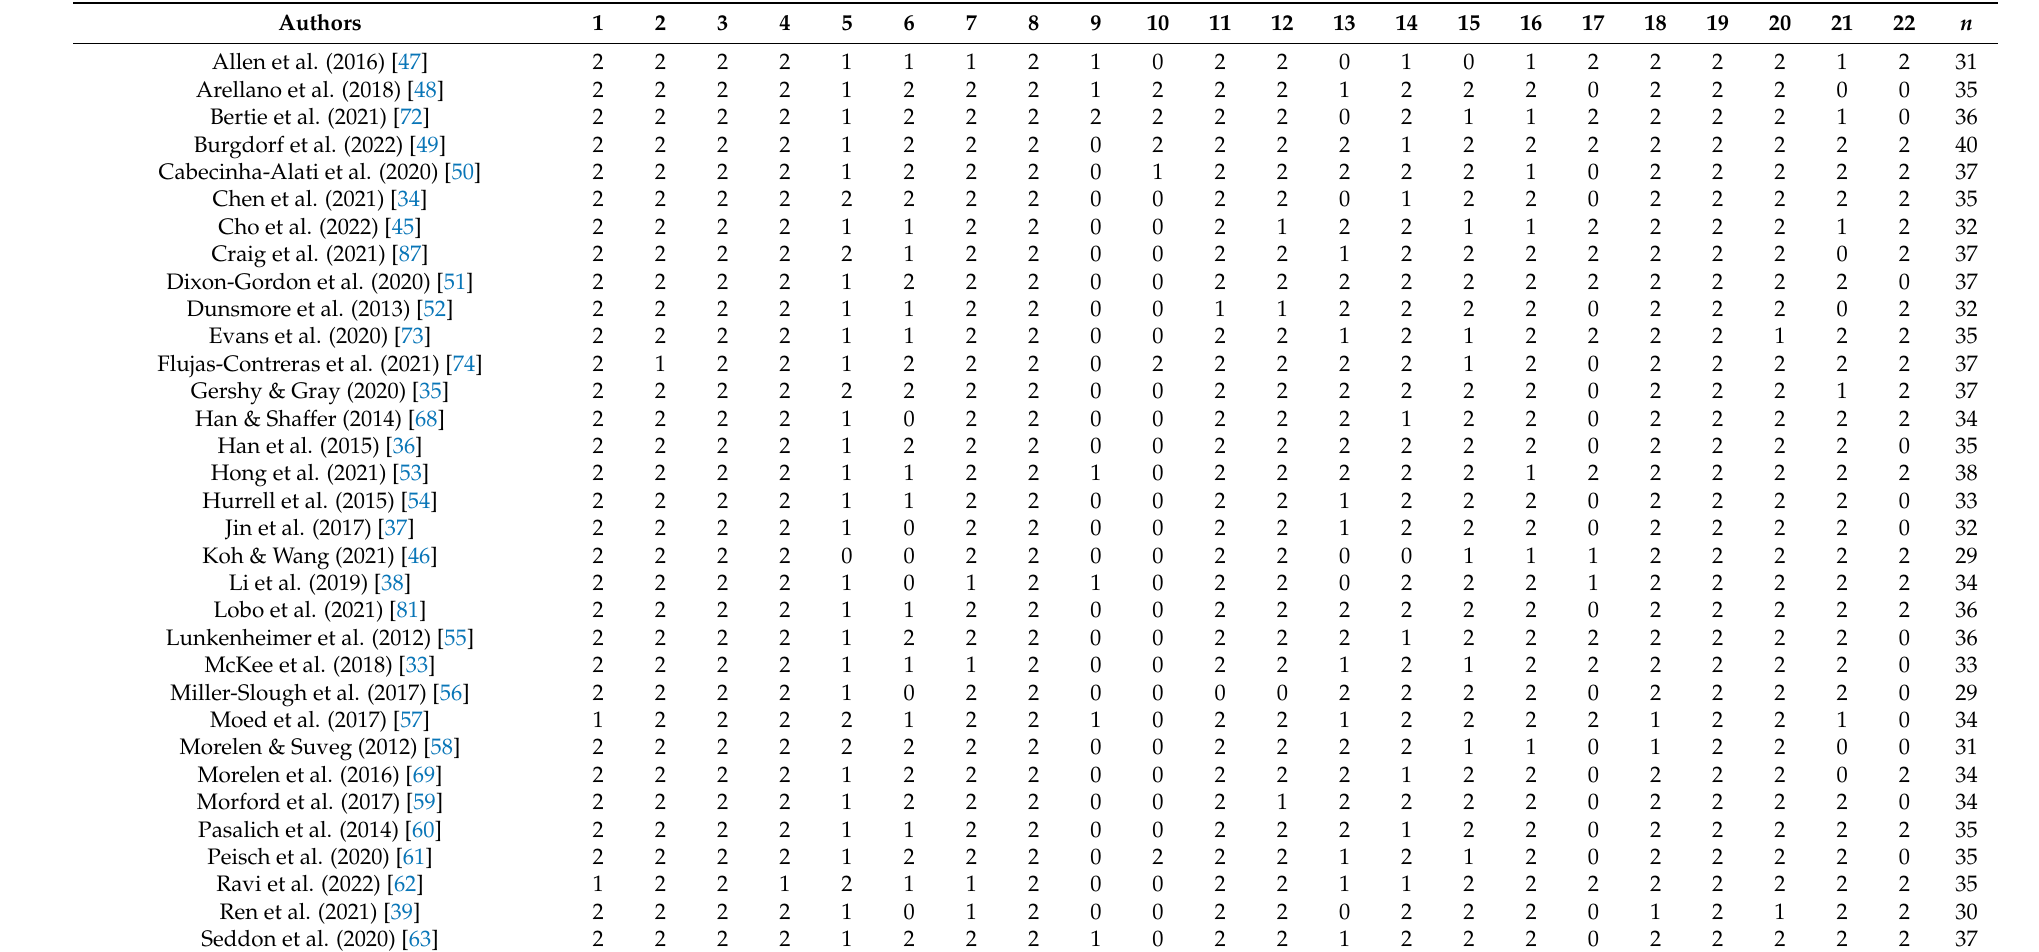
Table A1. Quality Estimation of the Included Observational Studies Using the STROBE